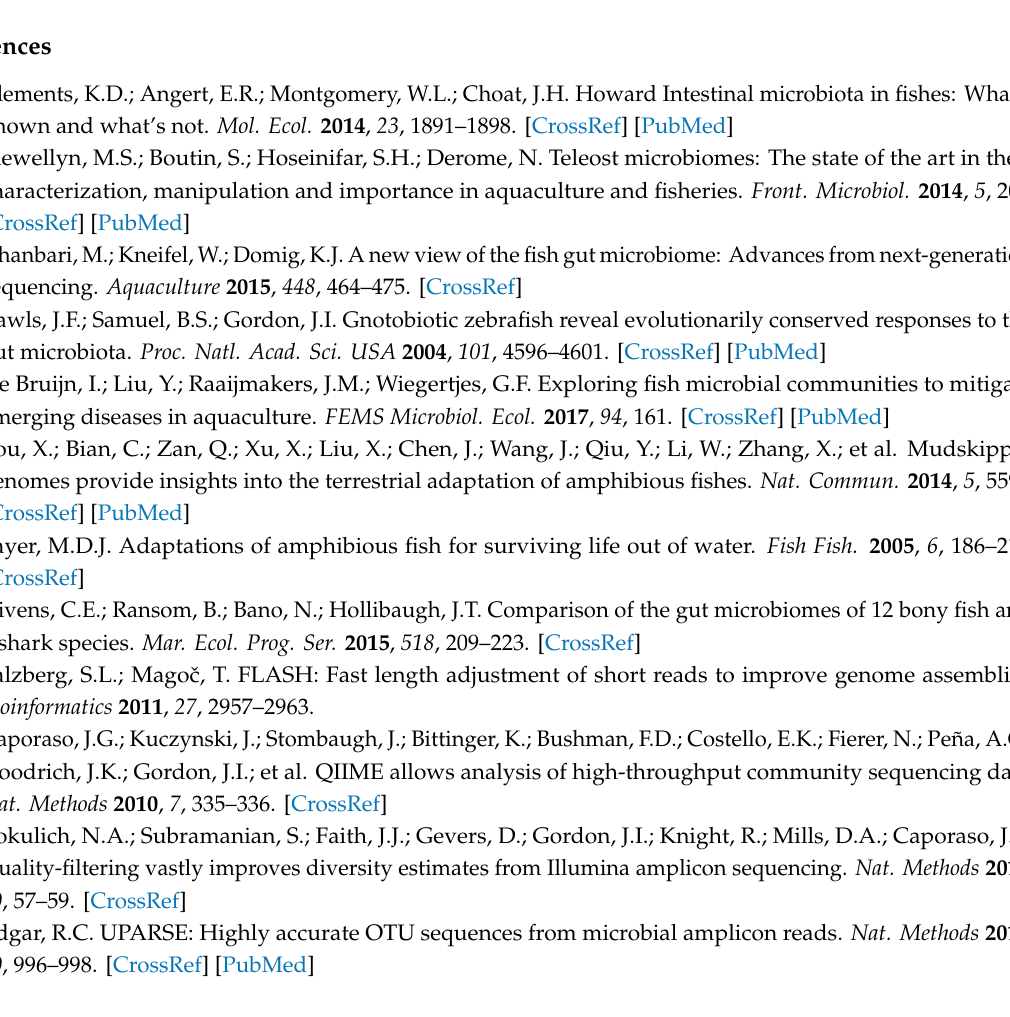
Table S1: Summary of the achieved data from 16S rDNA amplicon and metagenome sequencing; Table S2: OTU abundance, taxonomy, and comparisons among di ff erent vertebrate groups; Table S3: Alpha diversity values of all samples and comparison among groups; Table S4: Taxonomy relative abundance at level from phylum to species in each sample of 16S rDNA amplicon sequencing; Table S5: Di ff erential analysis of taxonomy relative abundance at the levels from phylum to species among various groups with di ff erent habitats and feeding habits; Table S6: Annotation of 155,217 assembled genes and taxonomy of 132,183 genes in the metagenome sequenced samples; Table S7: Relative abundance of genes in each metagenome sequenced sample; Table S8: Taxonomy relative abundance at the levels from phylum to species in each metagenome sequenced sample; Table S9: Significant analysis of taxonomic relative abundance at the levels from phylum to species between herbivorous BP and grass carp; Table S10: Significant analysis of functional pathways (via COG and KEGG) between BP and grass carp, and identification of bacteriocin-related genes in five fish